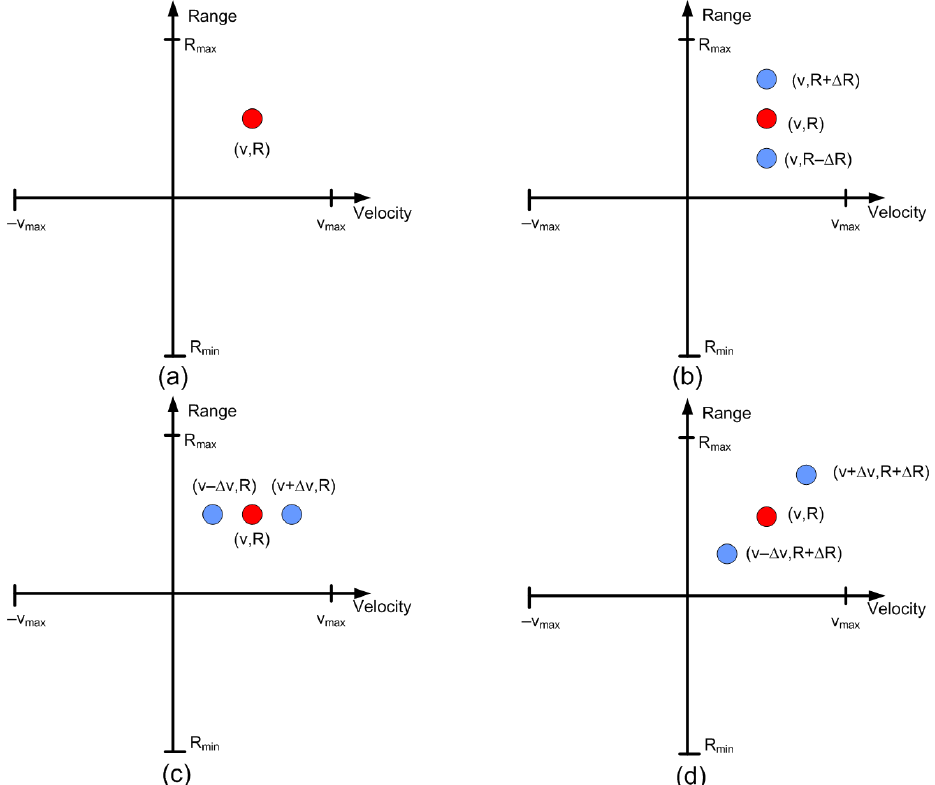
Figure 7. Ghost points introduced for the backscatter: ( a ) unmodulated case, ( b ) high-frequency modulation case with a modulation frequency integer multiple of f sd /2, ( c ) low-frequency modulation case, and ( d ) high-frequency modulation case where the modulation frequency is not an integer multiple of f sd